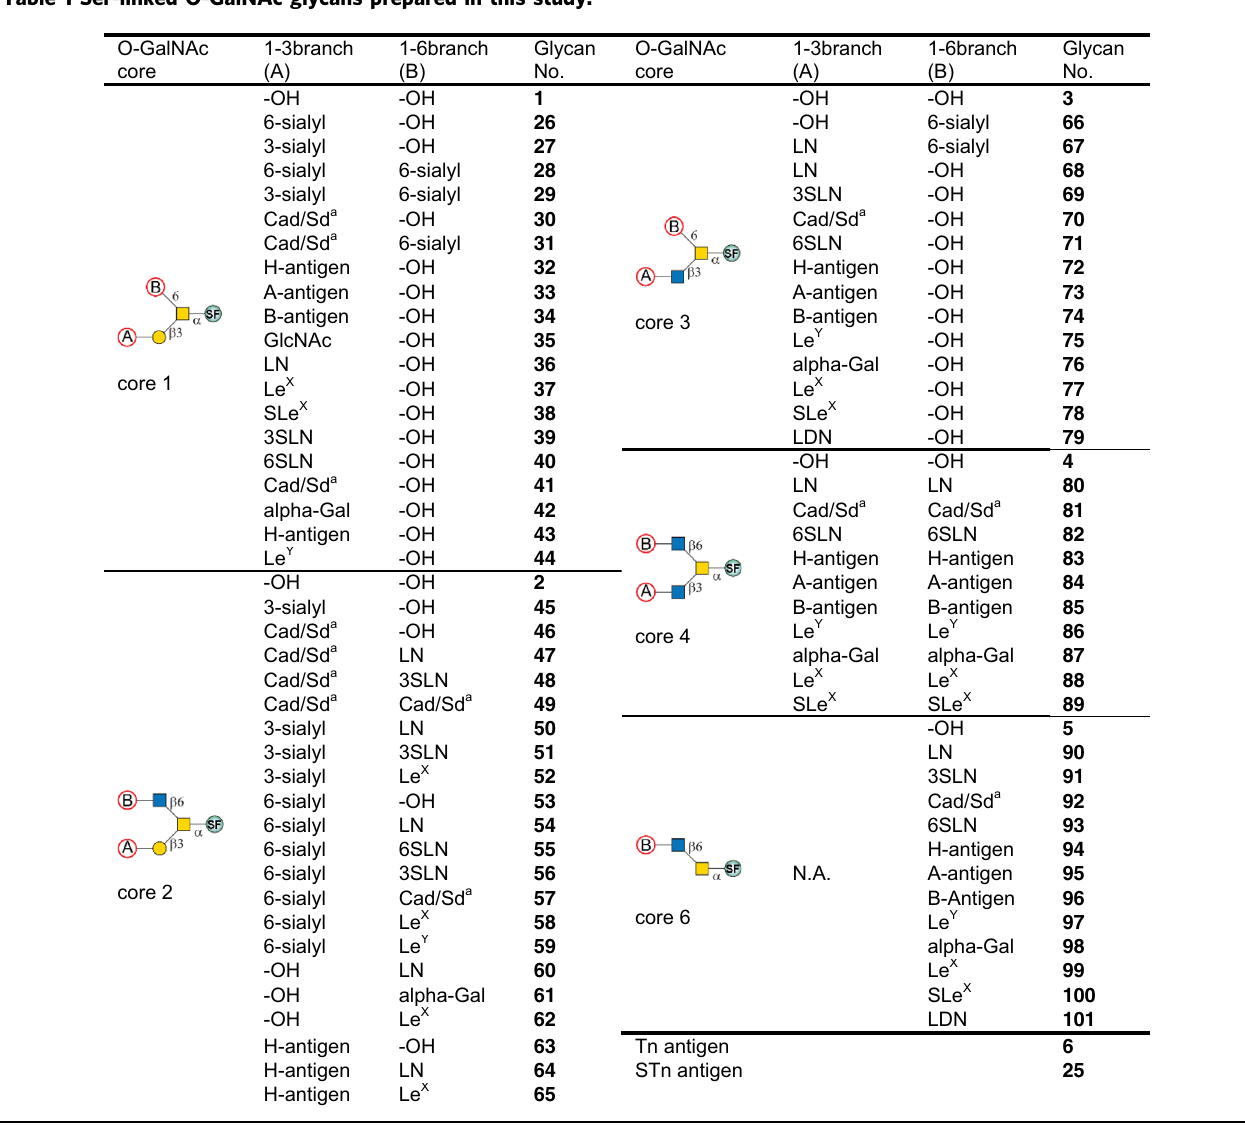
25 – 101 on N -hydroxysuccinimide (NHS)-activated glass slides. We assayed 17 commonly used GBPs and 2 recombinant in fl u-